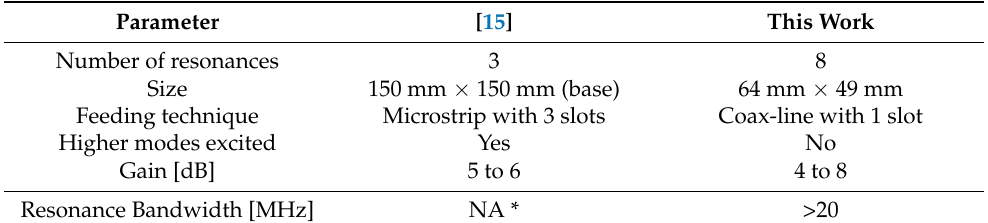
Table 3. Comparison of [15] and this